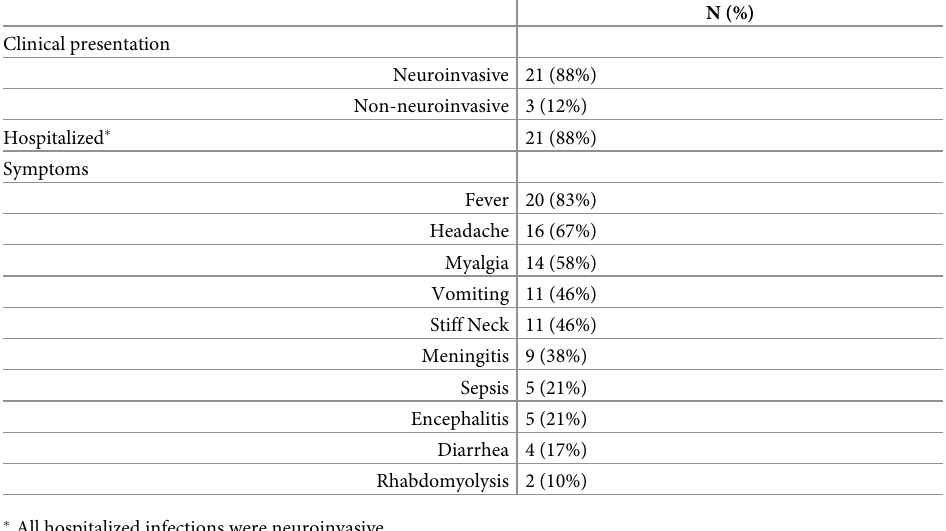
Table 4. Clinical presentations of the 24 St. Louis encephalitis virus (SLEV) cases reported in California, 2016–